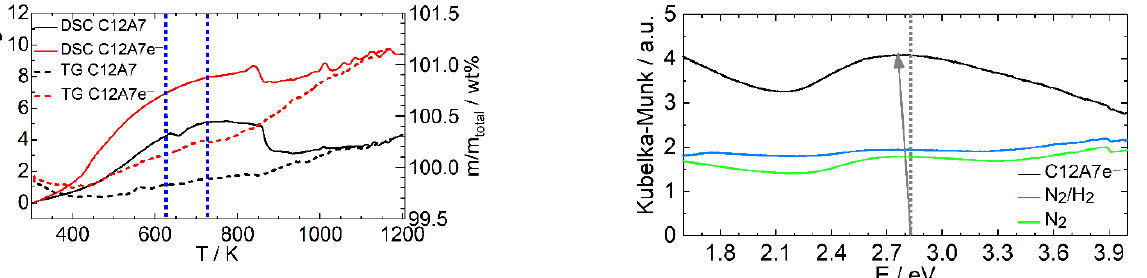
Figure 4. Reactivity test series of (d) C12A7e − (3C) under forming gas (95% N 2 /5% H 2 ) atmosphere inside the quartz-glass tube. From left to right: pictures of the sample after heating for each 1 h at the respective temperature.